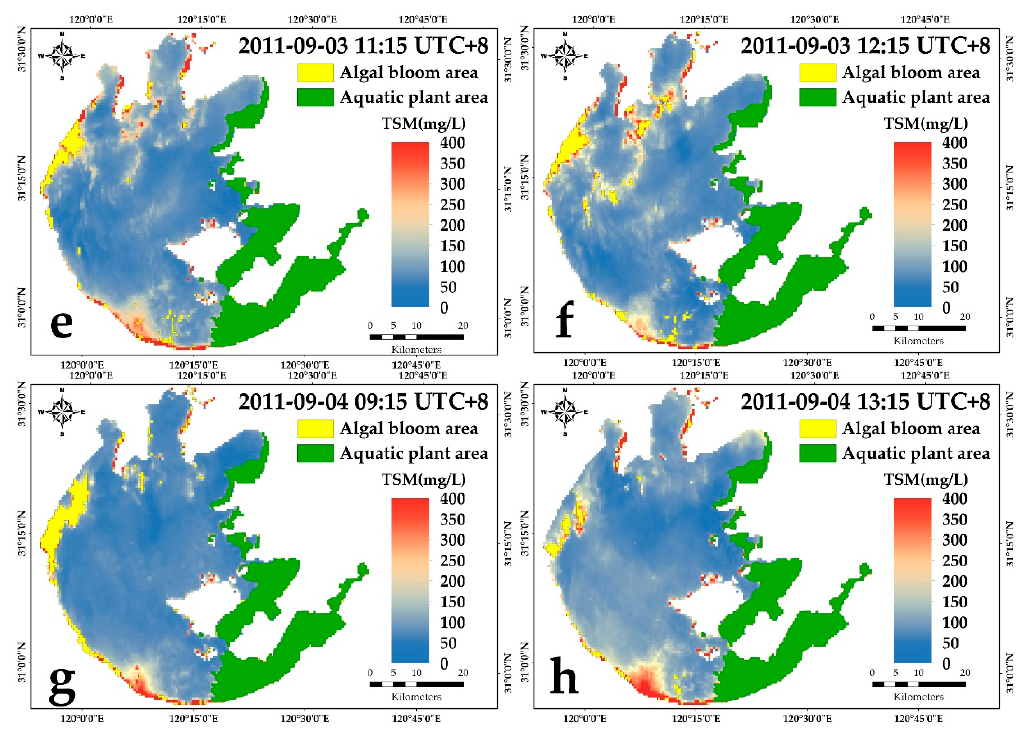
Figure 4. Distribution of TSM in Lake Taihu in early September 2011 (a-h) .